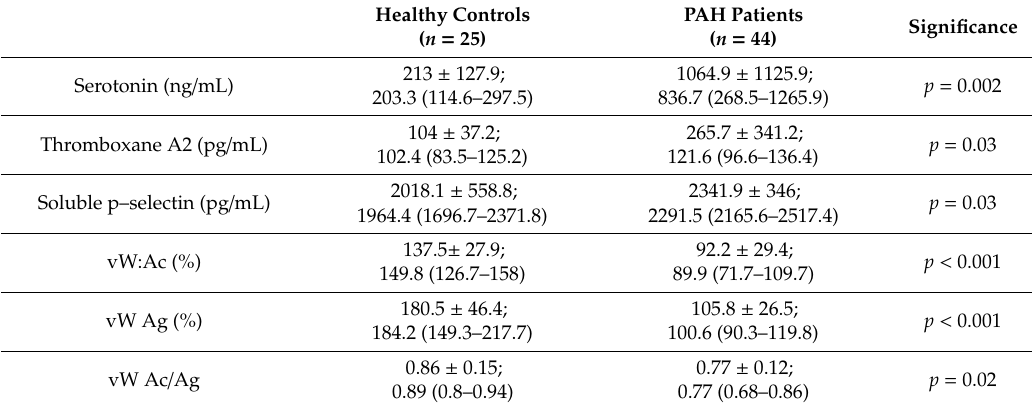
Table 5. Markers of platelet and endothelial dysfunction in patients with pulmonary arterial hypertension and healthy controls.